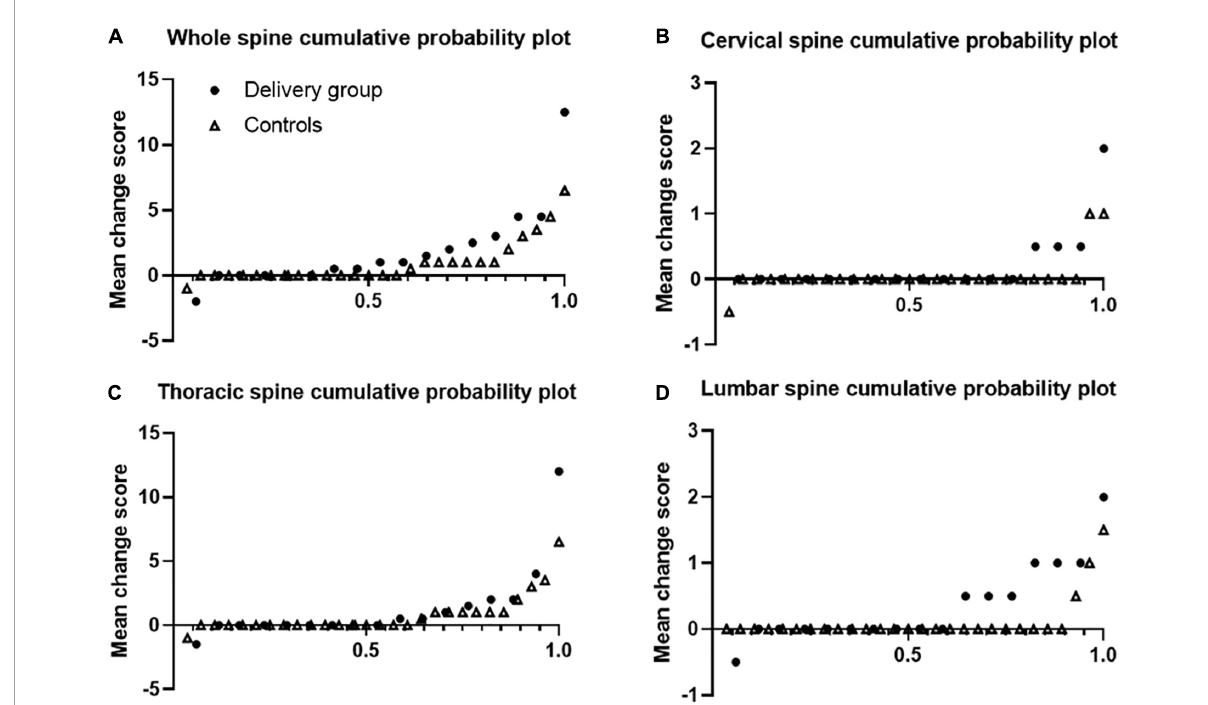
FIGURE1 Cumulative probability plots of progression of syndesmophytes. Syndesmophytes were scored with the computed tomography syndesmophyte score (CTSS). Plots are shown for the whole spine (A) , cervical (B) , thoracic (C) , and lumbar (D) segments. Dots represents delivery group and triangle represents control